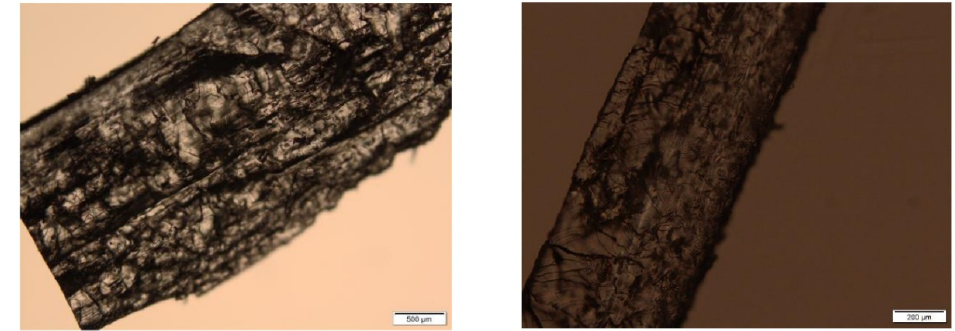
Figure 8. Cross section of tablets containing 5% of ATH after dissolution testing.